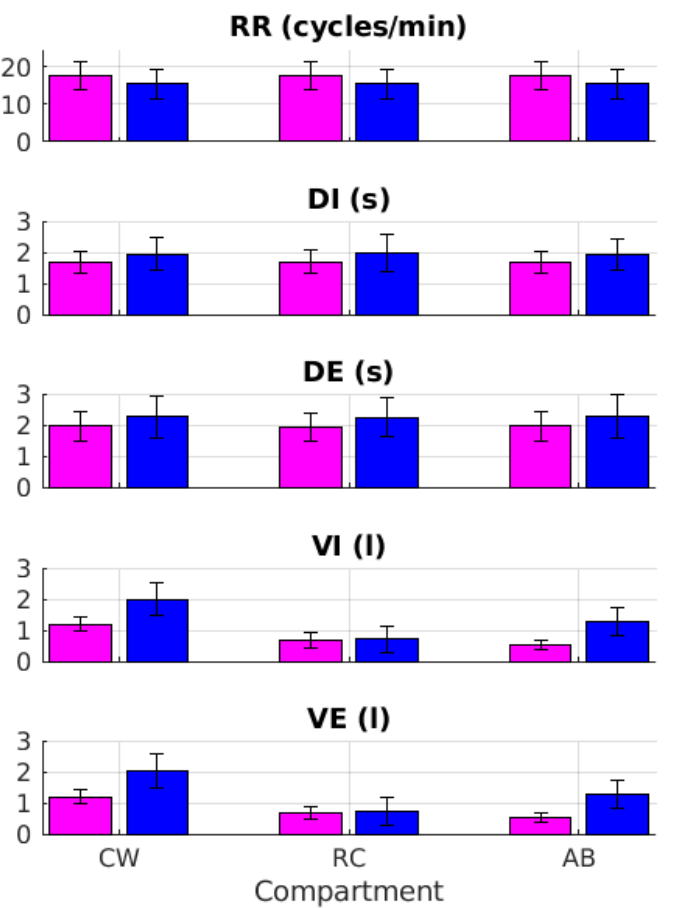
Figure 6. From top to bottom, the panels show mean and one standard deviation error bar for all respiratory variables (i.e., RR, DI, DE, VI, and VE), as measured by optoelectronic plethysmography, across compartments (i.e., CW, RC, and AB) for both female and male groups (pink and blue, respectively). Table 5. Outcomes of two-way ANOVA for the analysis of gender (2 levels: female and male) and compartment (3 levels: CW, RC, and AB) on the respiratory parameters measured by optoelectronic plethysmography (data reported in Figure 6). The p -values are highlighted in bold when reaching significance ( p <